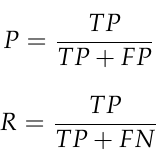
Figure 9. Training and testing accuracy of the models.